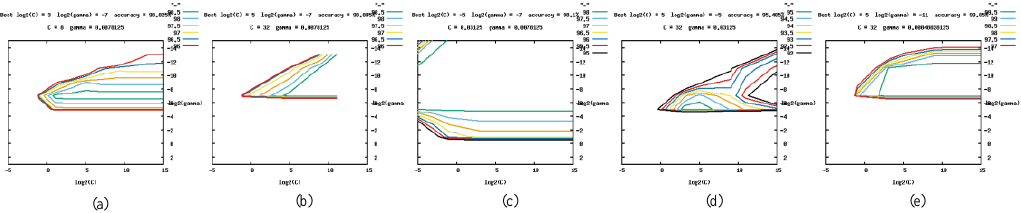
Figure 4. Parameter optimization figures under different feature fusion operation in the LivDet 2013 dataset from Biometrika: ( a ) addition operation; ( b ) maximum operation; ( c ) minimum operation; ( d ) average operation; ( e ) concatenation operation.